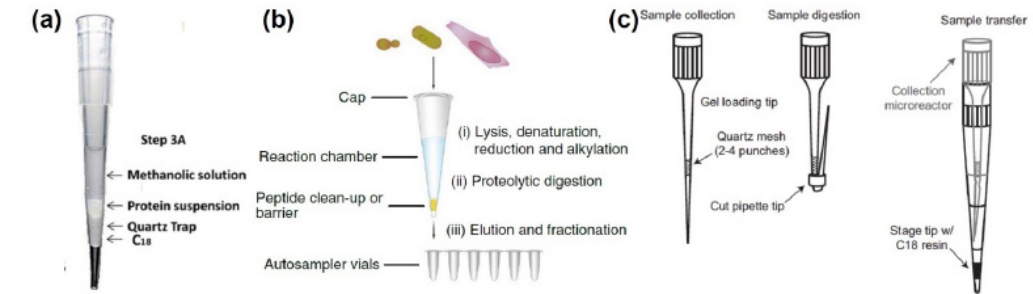
Figure 3. Advanced proteomic sample preparation for bulk MS-base proteomic analyses. ( a ) Representation of the suspension trapping (STrap) tip device. Adapted from reference [78] ( b ) In-Stage tip (iST) design for lysis and protein processing. Adapted from reference [77] ( c ) Combined S-Trap and iST design for streamlined proteomic sample processing for the analysis of fluorescence activated cell (FAC)-sorted cells. Adapted from reference [80].